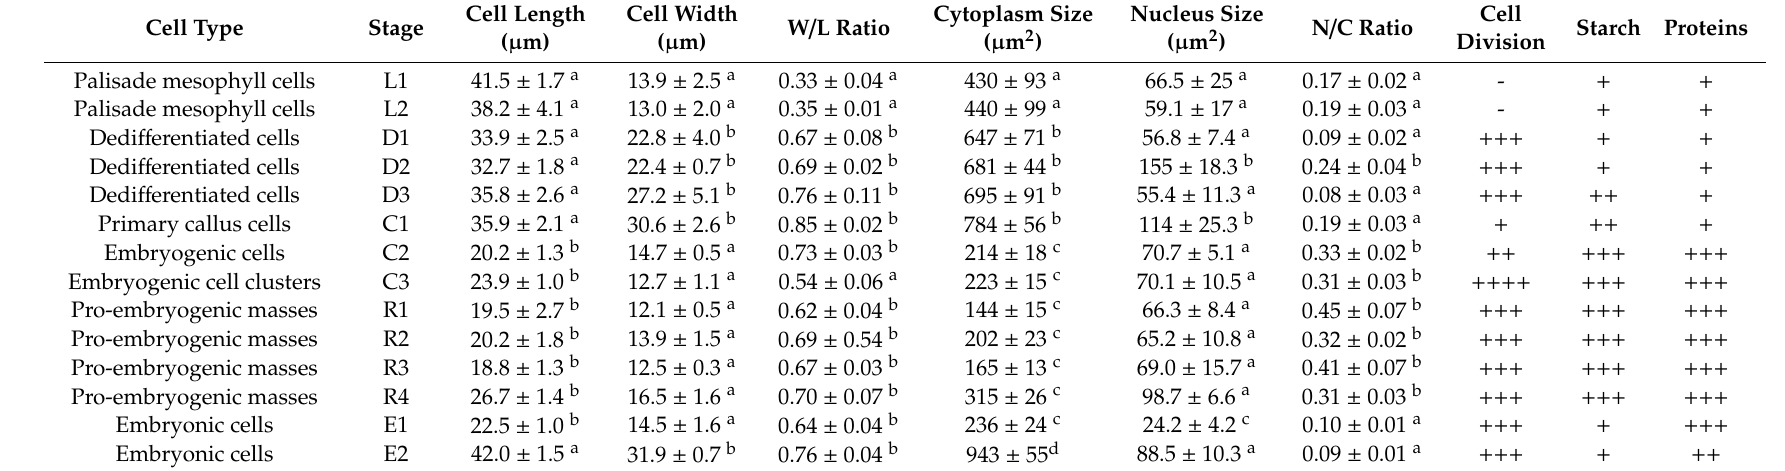
Values represent mean ± SD of 30 cells analyzed for each sampled stage. Stages correspond to: leaves from greenhouse plants (L1), explants during dedi ff erentiation [0 h (L2), 1 week (D1), 2 weeks (D2), 5 weeks (D3)], compact primary callus obtained 3 months after induction (C1), embryogenic callus obtained 7 months after induction (C2), established cell clusters obtained after 4 months in liquid proliferation medium (C3), pro-embryogenic masses [1 week in redi ff erentiation medium after auxin withdrawal (R1), 24 h in redi ff erentiation medium after reducing cell density (R2), 72 h (R3), 10 days (R4)], globular embryos (E1) and torpedo-shaped embryos (E2). W / L ratio corresponds to the mean of ratios between width and length for each cell. N / C ratio corresponds to the mean of ratios between nucleus and cytoplasm for each cell (nucleus-to-cytoplasm ratio). Cell division activity was estimated based on the number of cells in telophase. Starch granules were evidenced by the Schi ff reagent and soluble proteins were evidenced by Naphthol Blue Black. Di ff erences between the sampled stages were analysed with a one-way ANOVA test. Data followed by di ff erent letters in a same column are significantly di ff erent according to the Tukey post-hoc test ( P <